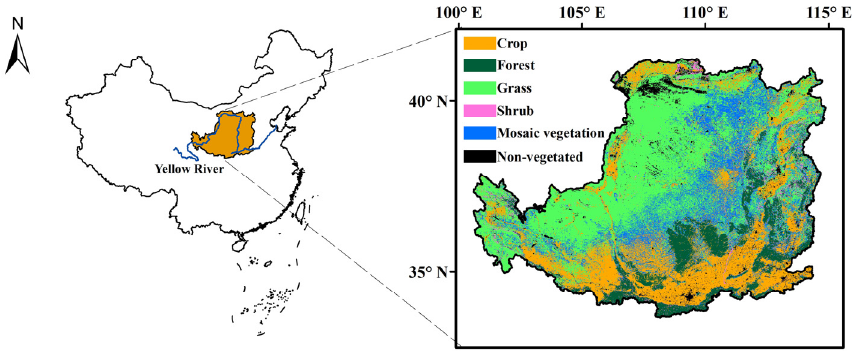
Figure 1. The geographical location of the LP and the spatial distribution of land cover types on the LP. Table 2. The area percentage change of the main land cover types on the LP from 2000 to 2015.